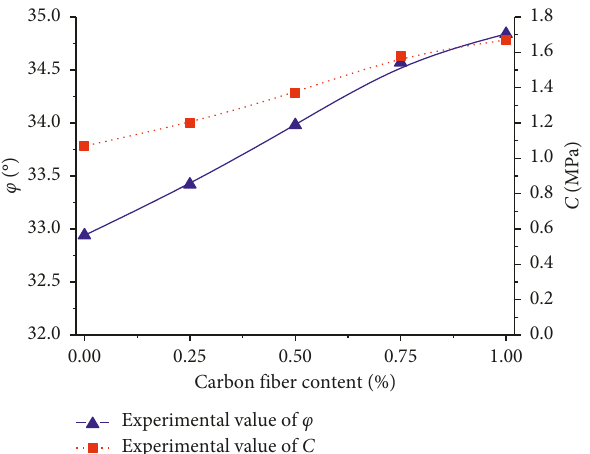
Figure 7: Computed shear strength parameters of the specimens with different carbon fiber contents. Figure